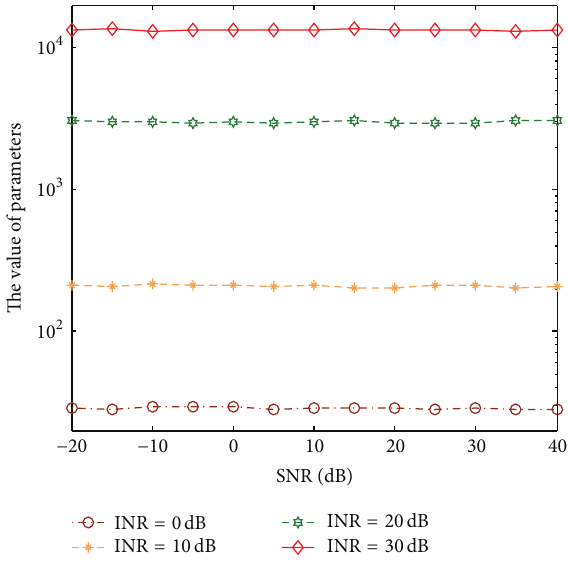
Figure 21: Output SINR versus the input SNR (INR = 40 dB).